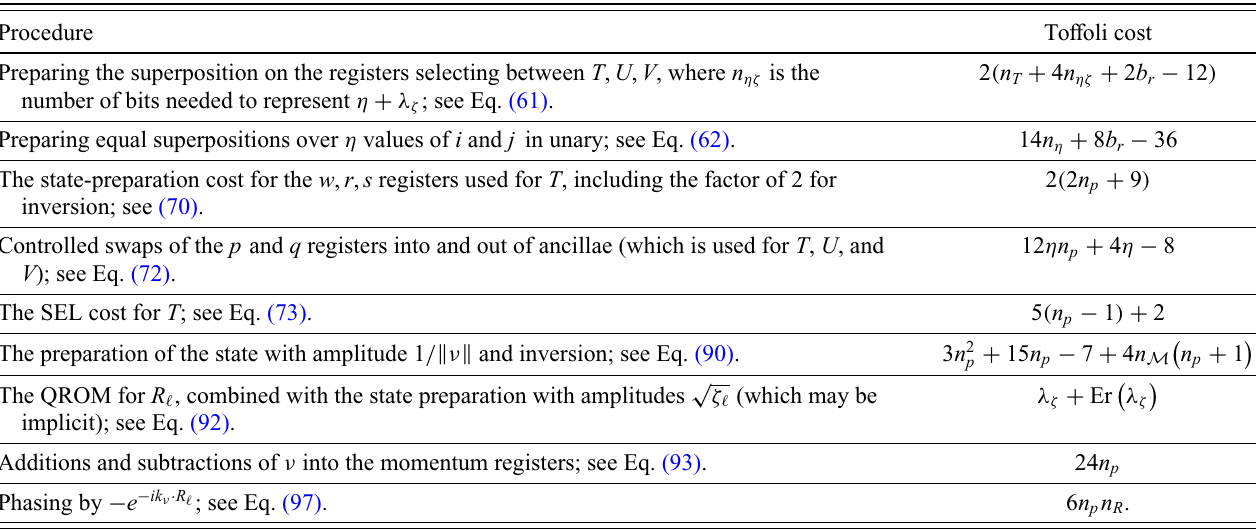
TABLE II. The costs involved in the block encoding of the Hamiltonian for qubitization. Procedure Toffoli